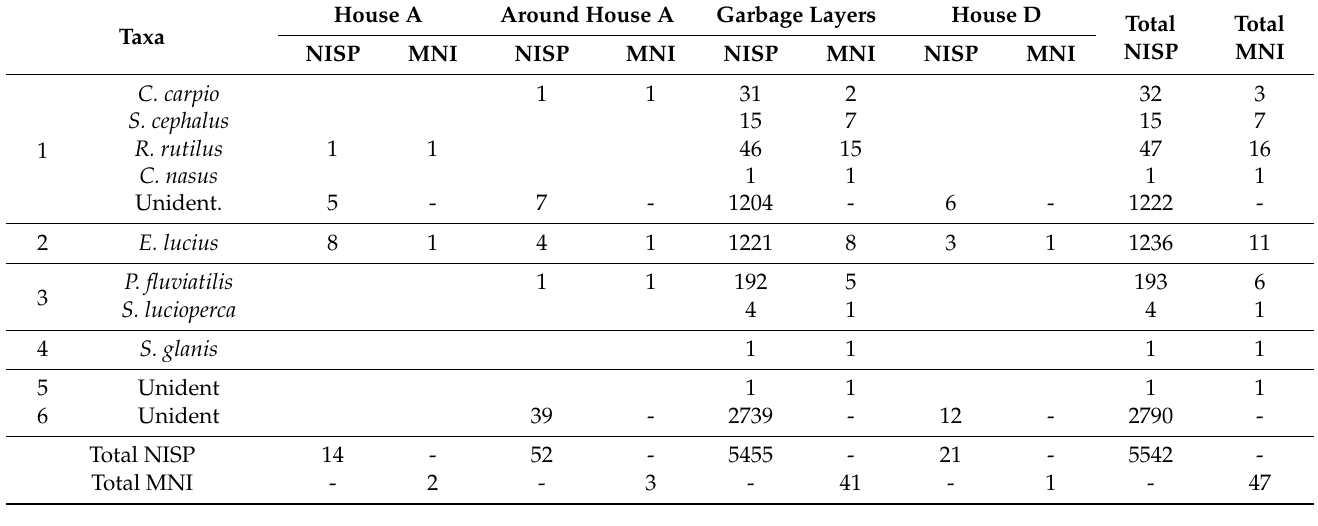
Table 2. Identified fish taxa from the studied layers in Borsodiv á nka 2020. NISP: number of identified specimens; MNI: minimum number of individuals. 1, Cyprinidae; 2, Esocidae; 3, Percidae; 4, Siluridae; 5, Salmonidae; 6, Teleostei. House A: layers S1066, S1081, S1100–1103, and S1105; Around House A: layers S1072, S1089, and S1097; House D: layer S1091; Garbage layers between House A and House C: layers S1119, S54–56, S6, and S7.